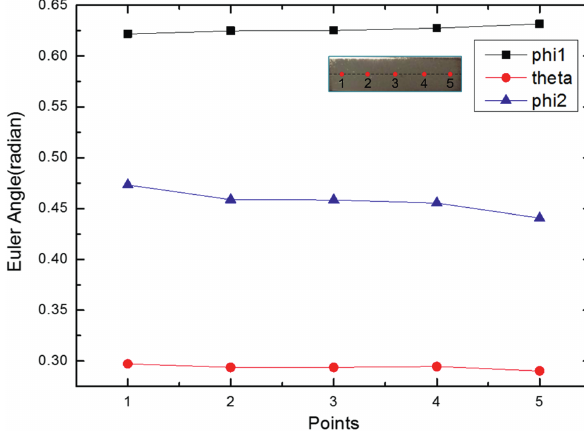
Figure 5: Three Euler angles vary with the selected points in the cut specimen of